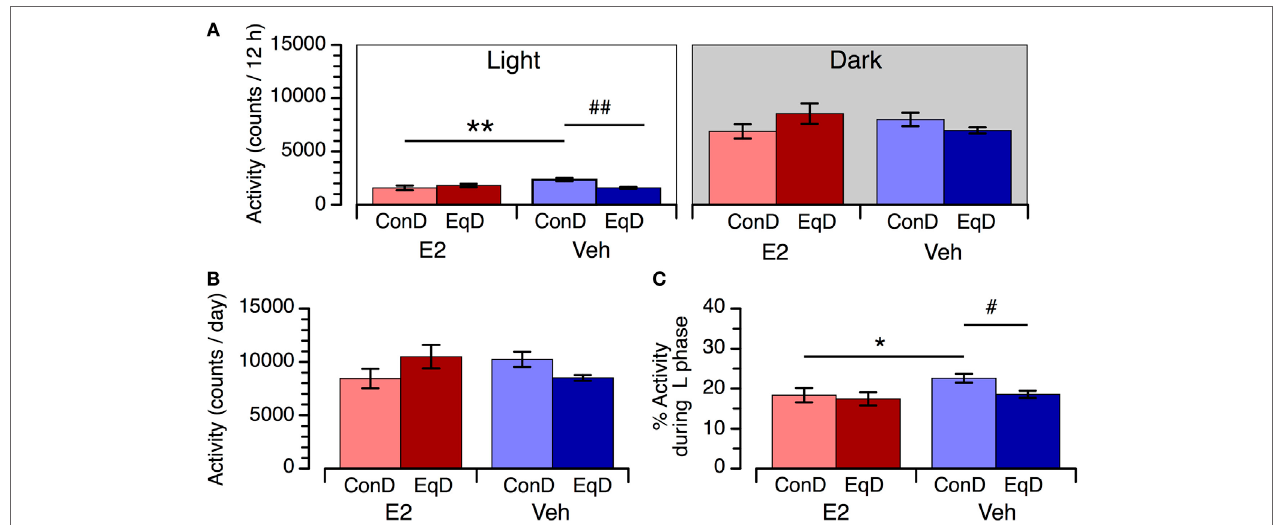
FigUre 3 | The effect of estradiol (E2) replacement and dietary S -equol on locomotor activity during the light phase [ (a) , left] and dark phase [ (a) , right], daily activity (b) , and percentage of daily activity during the light phase (c) in ovariectomized rats. Rats were ovariectomized and assigned to E2-replaced and cholesterol [vehicle (Veh)]-treated groups. These rats were fed a standard (control) diet (ConD) or an S -equol-containing diet (EqD). Values are shown as the mean ± SEM ( n = 6 in each group). * and **, significant differences ( P < 0.05 and P < 0.01, respectively) between the E2-replaced and Veh-treated rats fed the same diet; # and ## , significant differences ( P < 0.05 and P < 0.01, respectively) between the rats fed ConD and EqD with the same